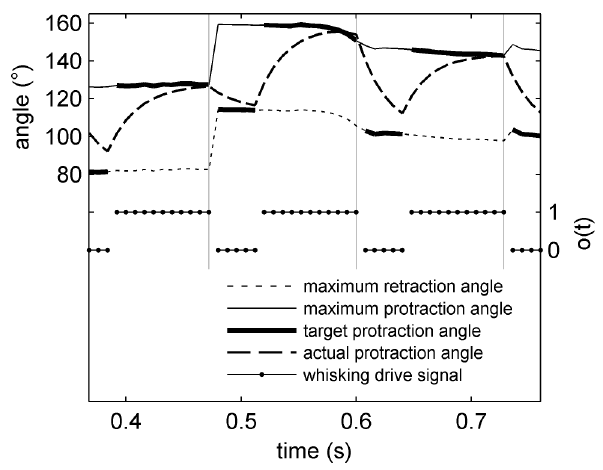
Figure 5. Whisking pattern generation. (Lower trace, axis to right) Solid line marked at each sample with dots is whisking drive signal, o ( t ) . (Upper traces, axis to left) Thin dotted and solid lines indicate maximum retraction and protraction angles ( h maxretr ( t ) and h maxprot ( t ) ), respective- w w ly, for one whisker (the most rostral whisker on the left). Overlaid thick lines show the target protraction angle, h tgt ( t ) , which is equal to w h maxprot ( t ) or h maxretr ( t ) depending on the value of o ( t ) (see Equation 9). w w Feint vertical lines show the time of oscillator ticks (times of falling edges in o ( t ) ). Actual whisker protraction angle, h w ( t ) , is indicated by the dashed line and is driven towards h tgt ( t ) . A sharp increase in w maximum protraction angle occurs shortly before 0.5 s; this change is reflected in the whisker protraction angle most strongly during the subsequent protraction which ends at around 0.6 s.